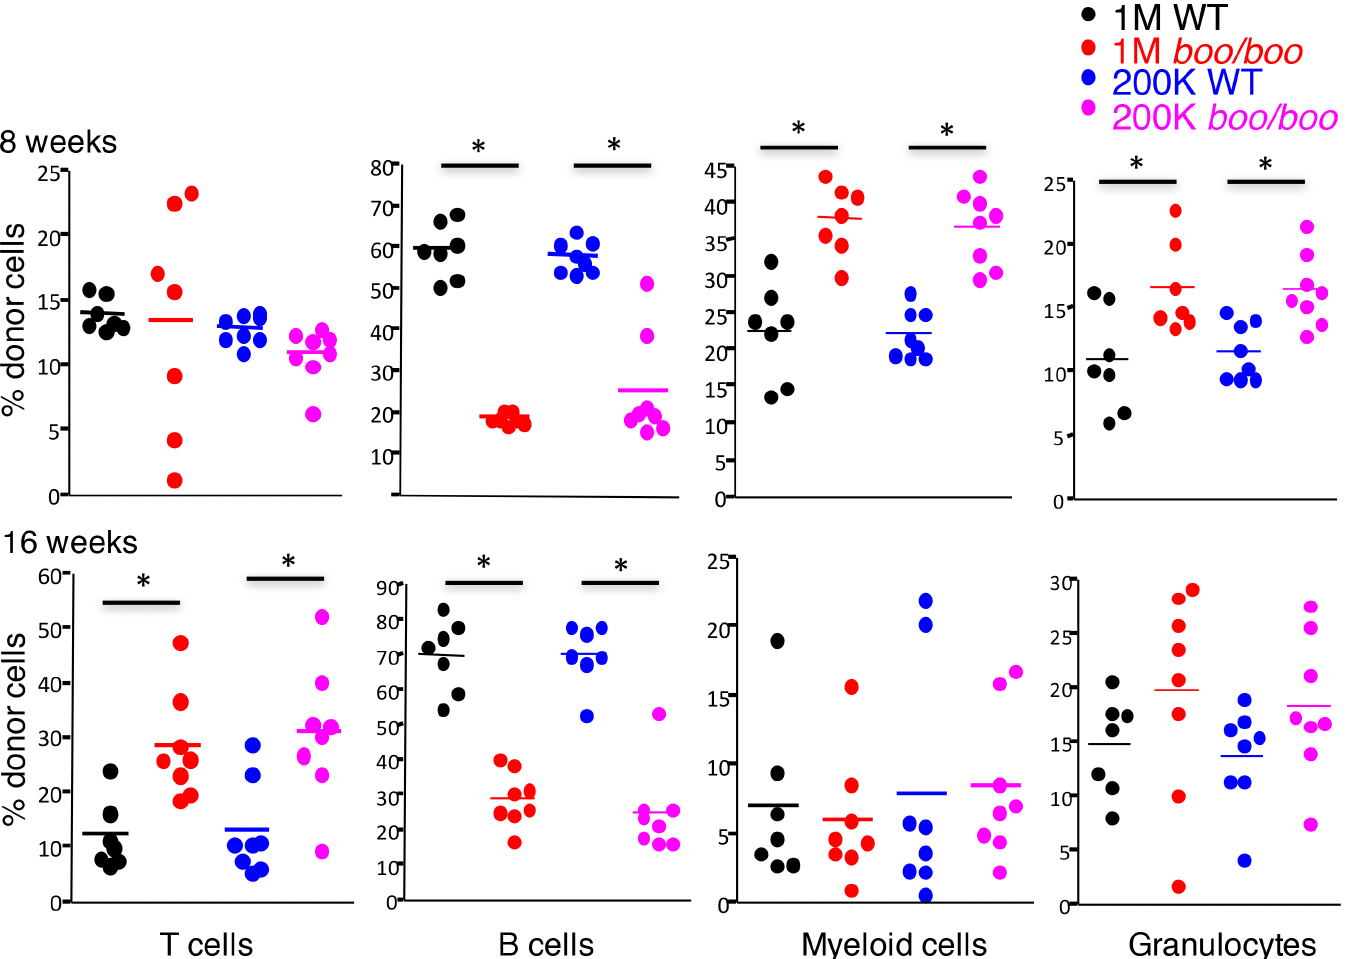
Fig 1. In vivo reconstitution potential of booreana fetal liver HSCs. Chimeraswere generatedto investigatethe in vivo reconstitution ability of booreana ( boo )versus WT fetal liver. Analysesinvolveda quantitative and kinetic study of the lineagepotential of 1 x 10 6 (1M) or 2 x10 5 (200K) fetal liver cells from boo/boo and WT mice of CD45.2origin transplantedinto lethally irradiatedCD45.1 mice. Donor cell reconstitution was assessedvia flow cytometric analysis of subsets in peripheral blood of chimeras at 8 and 16 weeks post reconstitution. The proportional representation of T cells (CD3 + ), B cells (B220 + ), myeloid cells (CD11b + ) and granulocytes (Gr1 + ) was measured within the donor-derived (CD45.2) leukocyte compartment of peripheralblood.Individualdata points are shown, with mean value indicatedby a horizontal bar. All comparisons betweenequivalent boo/boo and wild type chimeras were significantly different (p (cid:20) 0.05) except for T cells at 8 weeks, and macrophages and granulocytes at 16 weeks. More completedata at 4, 8, 12 and 16 weeks are summarised in S3 Fig. Significantlydifferent data sets are shown by * .